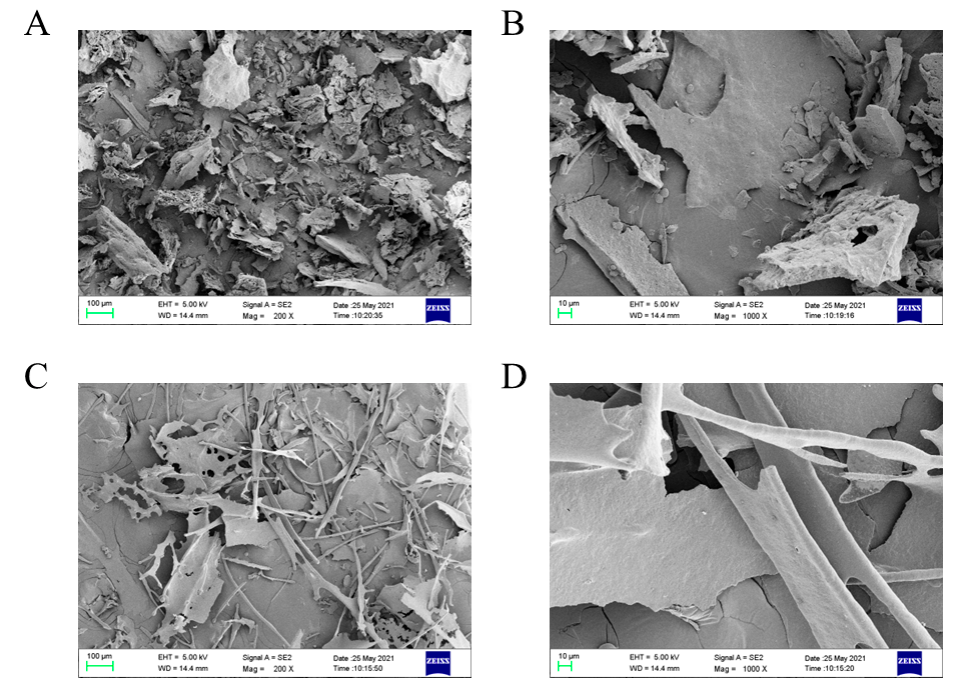
Figure 2. Morphological features of GPs and their Zn (II) derivatives. ( A , B ) SEM images of GPs at magnifications of 200 × and 1000 × , respectively; ( C , D ) SEM images of GP–Zn (II) complexes at magnifications of 200 × and 1000 × , respectively.